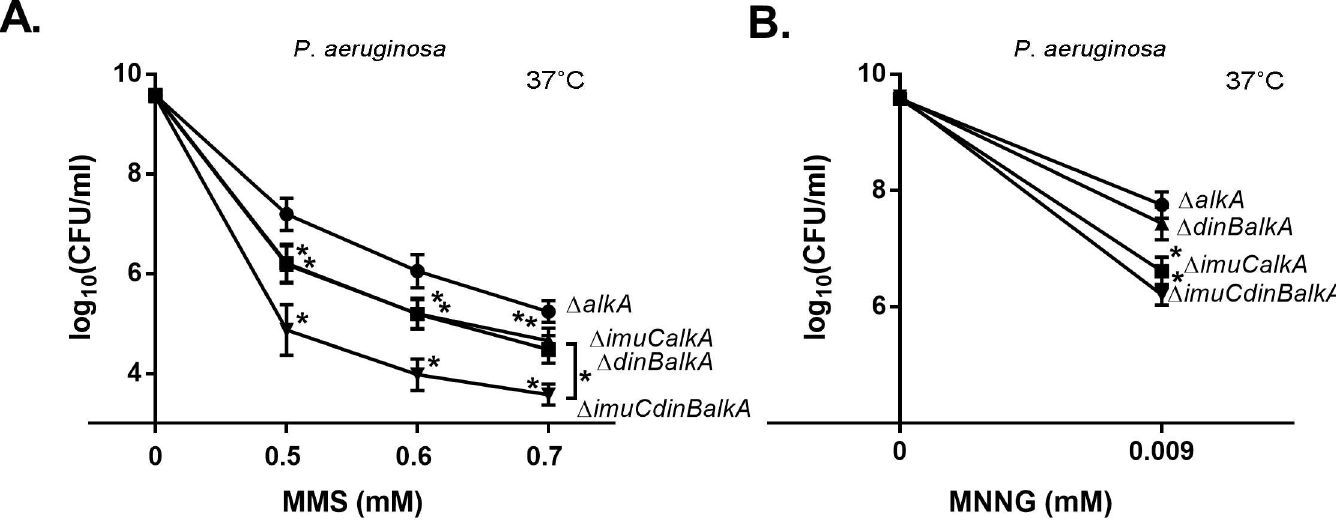
Fig 5. Sensitivity of P . aeruginosa Δ alkA strain and its TLS polymerase-deficient derivativesto MMS and MNNG. Sensitivity was estimated by spotting 10-fold dilutionsof overnightcultures onto LB plates containingdifferent concentrations of MMS (A) and MNNG (B), and incubatedat 37˚C for 24 h. Data represents the mean ( ± 95%CI)values. ( ● ) Δ alkA ; ( ■ ) Δ imuCalkA ;( ▲ ) Δ dinBalkA ;( ▼ ) Δ imuCdinBalkA . Asterisks indicatestatisticallysignificant difference ( P < 0.05; two-way ANOVA followedby Tukey’s multiplecomparisonpost hoc test) in the sensitivity of the Δ alkA mutant in comparisonwith the other deletionmutants. In addition, significantdifference in sensitivity betweenthe strains Δ imuCalkA or Δ dinBalkA and the Δ imuCdinBalkA (A) is indicated.